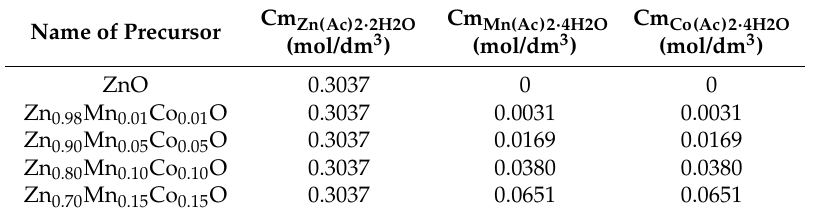
Table 3. Compositions (nominal content) of precursors of Zn (1 − x − y) Mn x Co y O